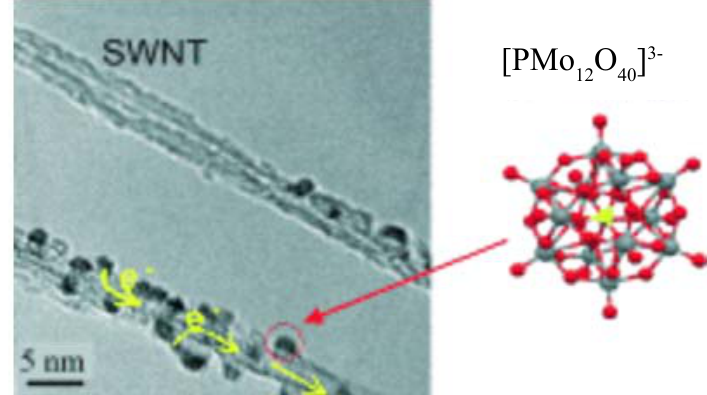
Fig. 10. TEM image of the POM/SWNT hybrid material. Adapted from Ref [62].